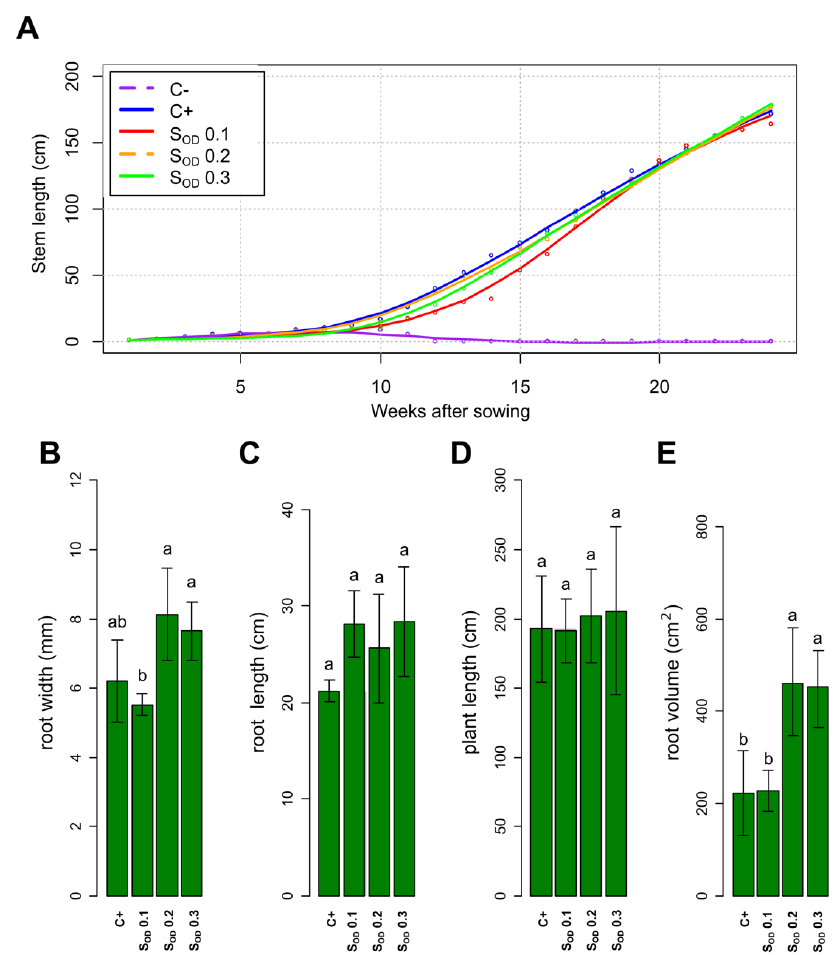
Figure 5. Growth parameters of tomato plants in the greenhouse experiment. ( A ) Stem length from week one to week 24 after sowing, C − : plants died at week seven due to the absence of mineral nutrients in the soil (purple line). ( B ) Root width at week 24 after sowing. ( C ) Root length at week 24 after sowing. ( D ) Plant length at week 24 after sowing. ( E ) Root volume at week 24 after sowing. Different letters show statistically significant differences (Tukey p < 0.05).